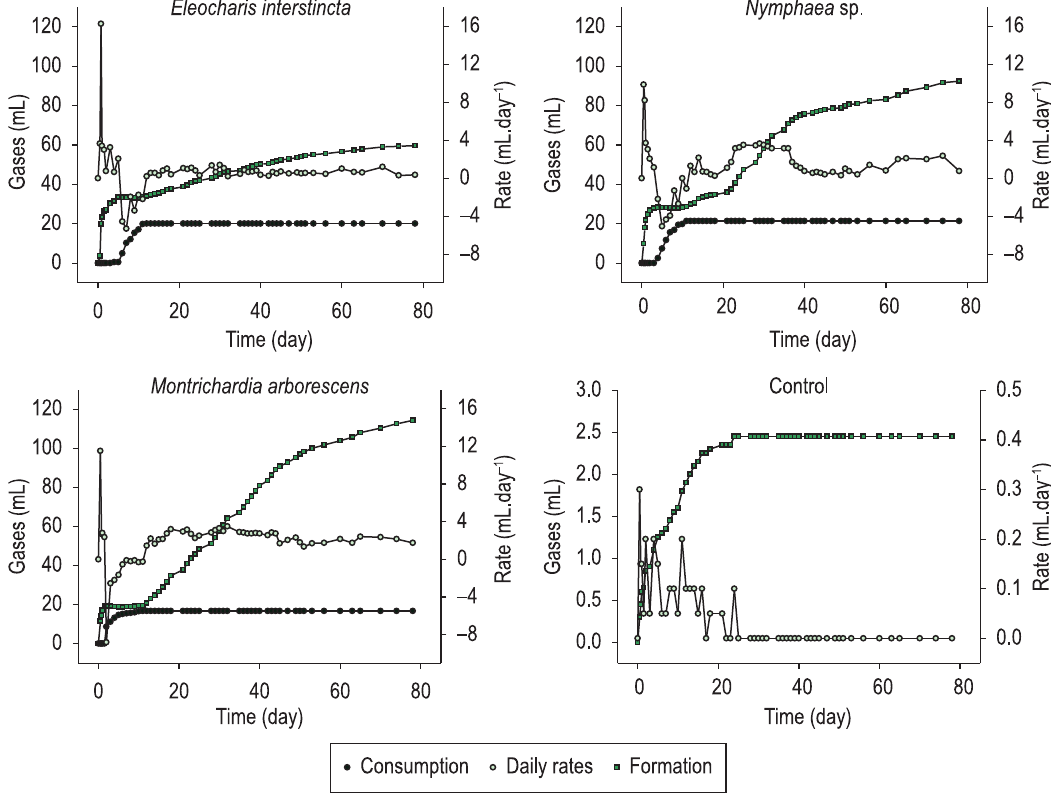
Figure 2. Gases formation and consumption during anaerobic decomposition of E. interstincta , Nymphaea sp. and M. arborescens